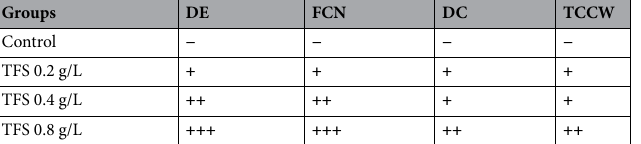
Table 3. Effect of Trifloxystrobin on selected biochemical parameters. The averages shown with different letters (a–d) in the same column are significantly different at p < 0.05.